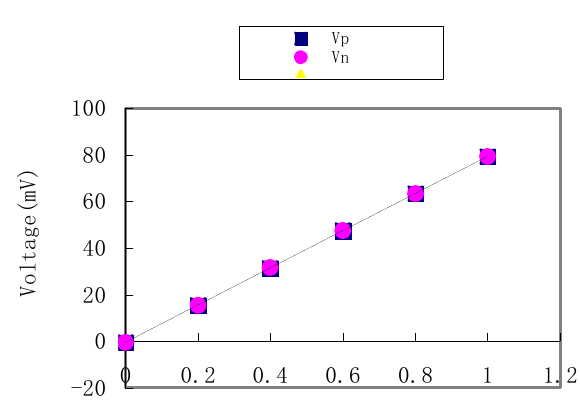
Figure 7. Output of the